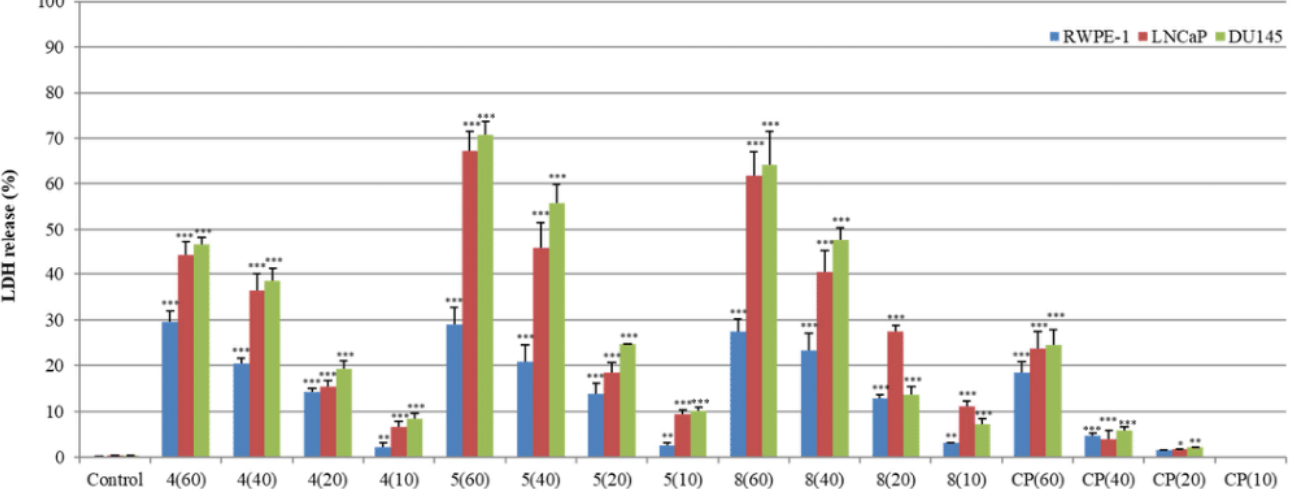
Figure 2. The amount of released lactate dehydrogenase (%) in cancer (LNCaP and DU145) and normal (RWPE-1) cell lines. Conjugates with oleic ( 4 ), elaidic ( 5 ) and DHA acid ( 8 ) and free ciprofloxacin (CP) were tested at concentrations of 60 µM, 40 µM, 20 µM and 10 µM. Significance levels explanation *** p < 0.001; ** p < 0.01;* p < 0.1 as compared to the control.